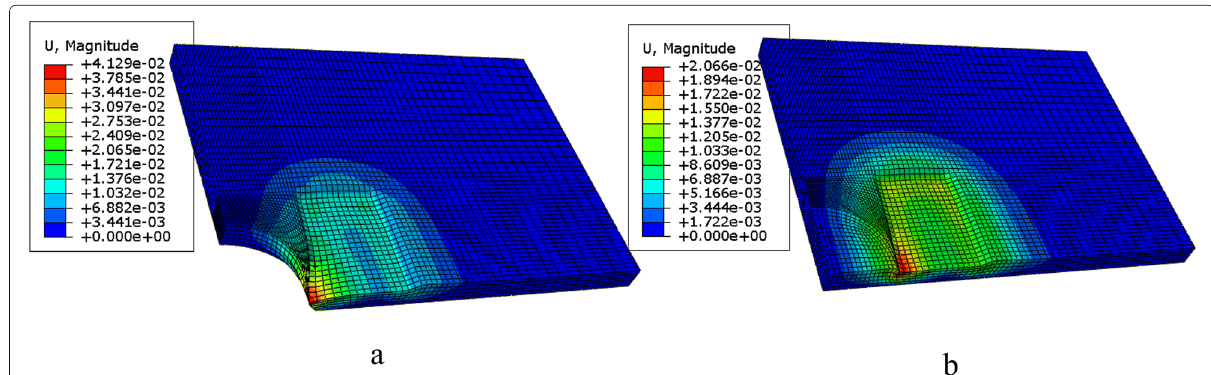
Fig. 5 Maximum deformation of the surface layer with and without patches